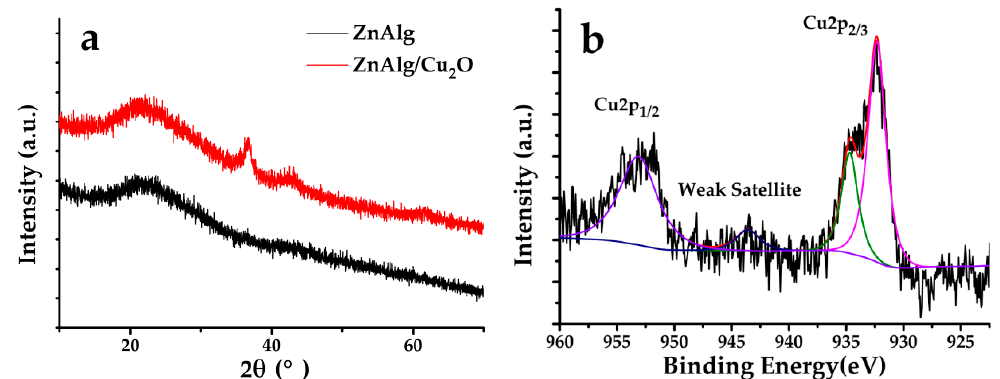
Figure 2. ( a ) X-ray diffractometry (XRD) patterns of ZnAlg and ZnAlg/Cu 2 O and ( b ) main and satellite peaks of Cu 2p3/2 and Cu 2p1/2 of the X-ray photoelectron spectroscopy (XPS) spectra for ZnAlg/Cu 2 O.